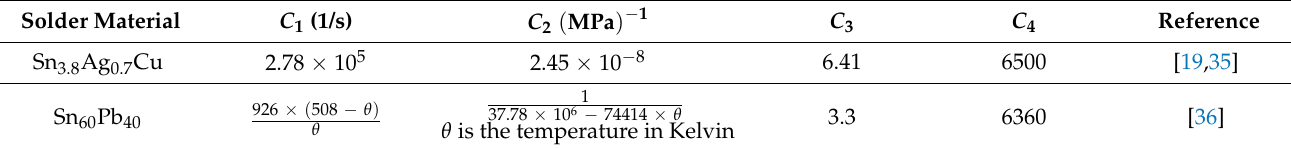
Table 4. Creep parameters for Garofalo–Arrhenius